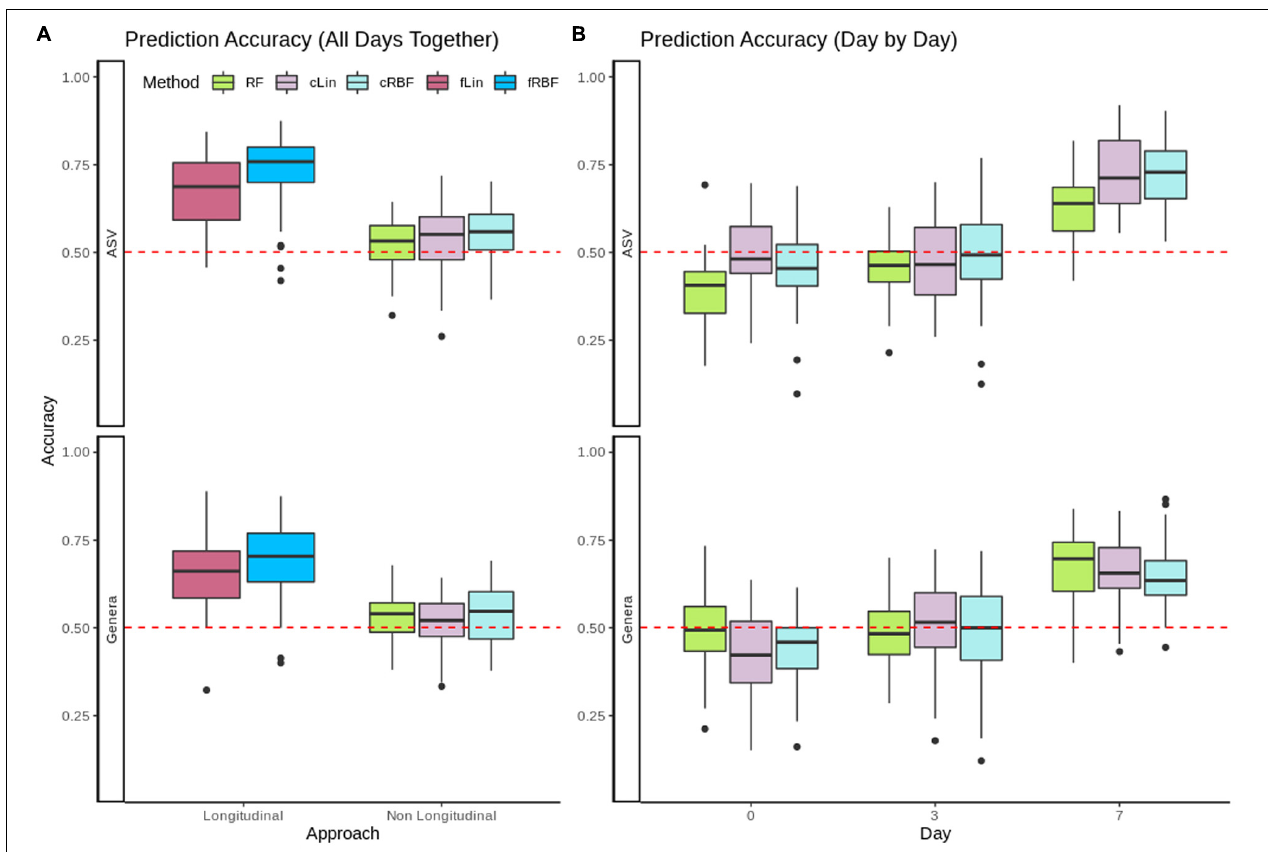
FIGURE 4 | (A) Accuracy for RF, non-longitudinal kernels (cRBF, cLin) and Longitudinal kernels (fLin, fRBF) in the prediction of neonatal diarrhea from all available days. (B) Accuracy for RF and non-longitudinal cLin and cRBF kernels from metagenomic data of days 0, 3, and 7 post-birth separately. In both panels, the red dashed line marks the accuracy of the random